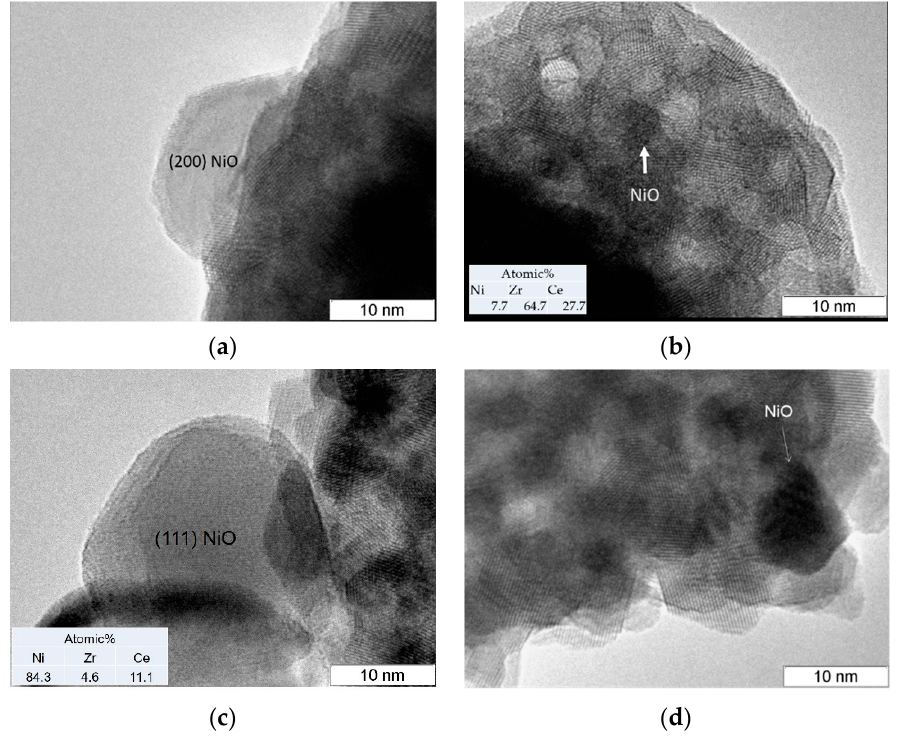
Figure 7. TEM images of Ni-Ce x Zr 1-x catalysts prepared by one-pot method and by impregnation: (a) Ni-Ce 0.3 Zr 0.7 im, (b) Ni-Ce 0.3 Zr 0.7 op, (c) Ni-Ce 0.7 Zr 0.3 im, and (d) Ni-Ce 0.7 Zr 0.3 op.